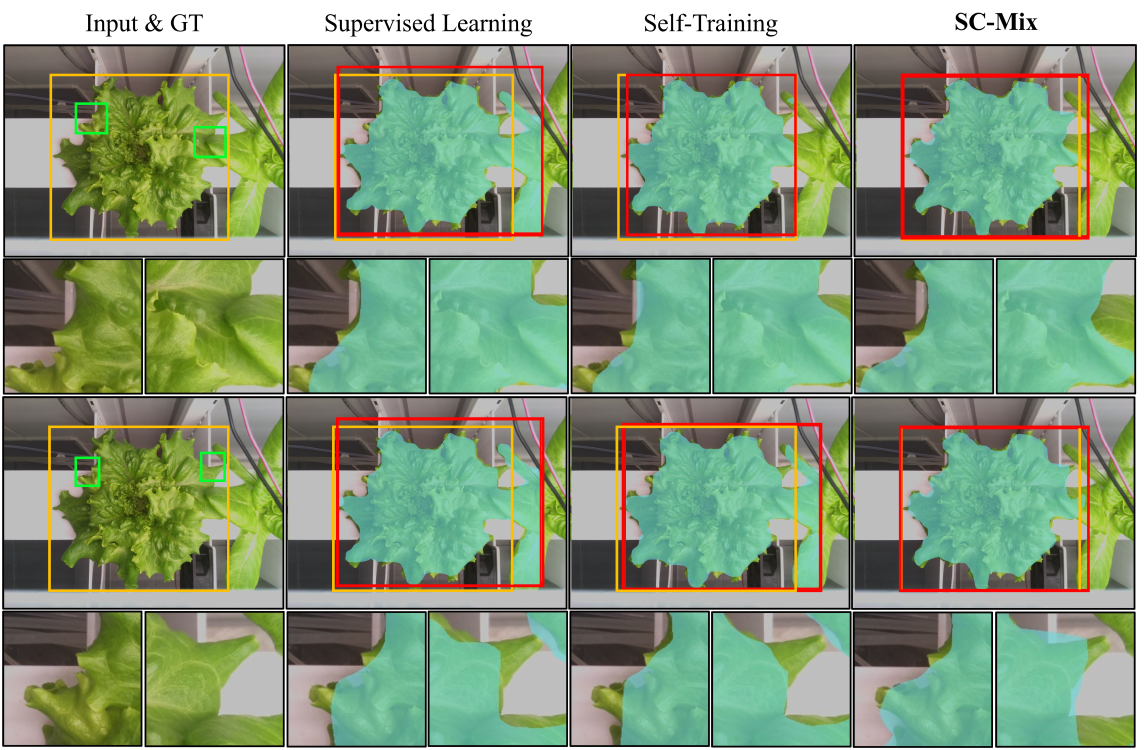
Figure 7. Supervised vs. self-training vs. SC-Mix. This result compares SC-Mix to other model training approaches for overlapping crops. The red box is the predicted area of the model, and the yellow box is the ground truth area of the